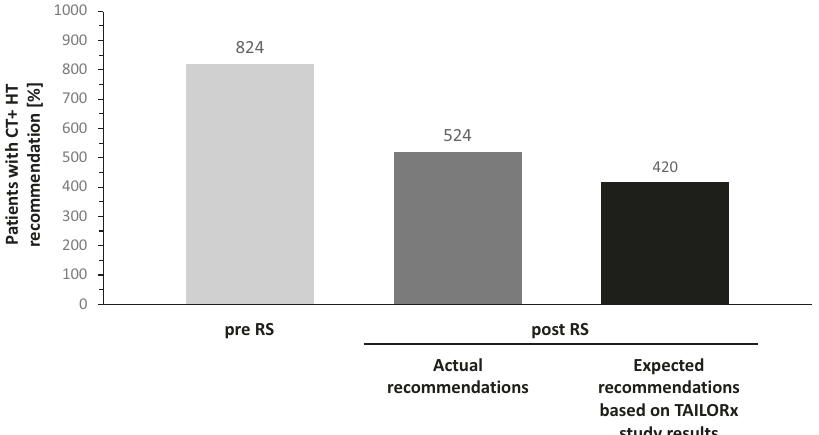
Fig. 2 Patients with post-RS recommendations for chemo-endocriine therapy (CT + HT): actual number based on previous RS cut points and expected percentage assuming decision-making according to TAILORx results (N = 1683). Pre RS: treatment recommendations before avalability of the Recurrence Score result. Post RS: treatment recommendations accounting for the Recurrence Score result.